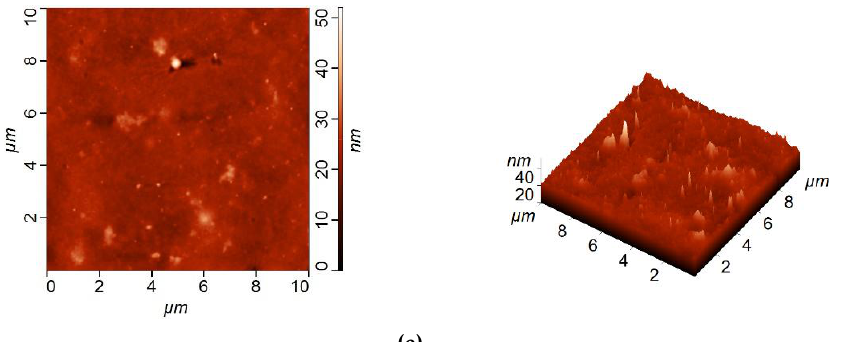
Figure 6. AFM images of the selective layer surface of TFN membranes: ( a ) D30; ( b ) D30-IP; ( c ) D30-IP1; ( d ) D30-IP3; ( e ) D30-IP5.